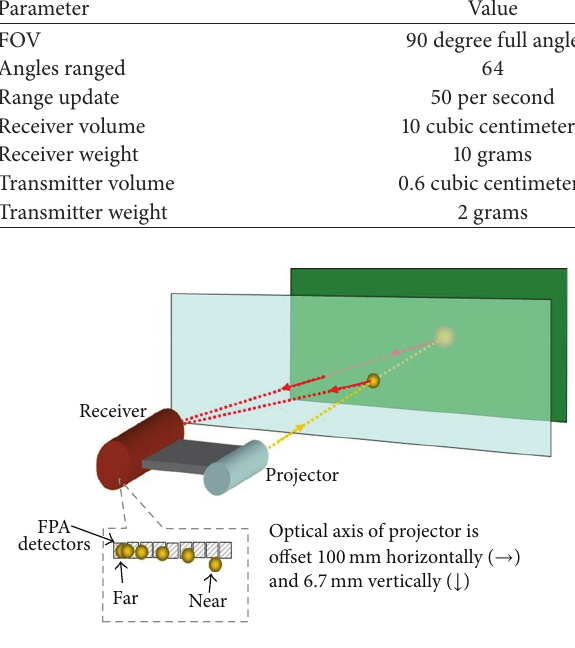
Figure 1: LRS concept.